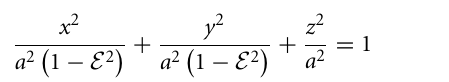
FIGURE 1 | (A) A microscope image (Bar = 1 μ m) of a rod-shaped magnetotactic bacterium found in Lake Miyun near Beijing, China. (B) An elongated prolate spheroid with eccentricity E = 0 . 96 that provides an